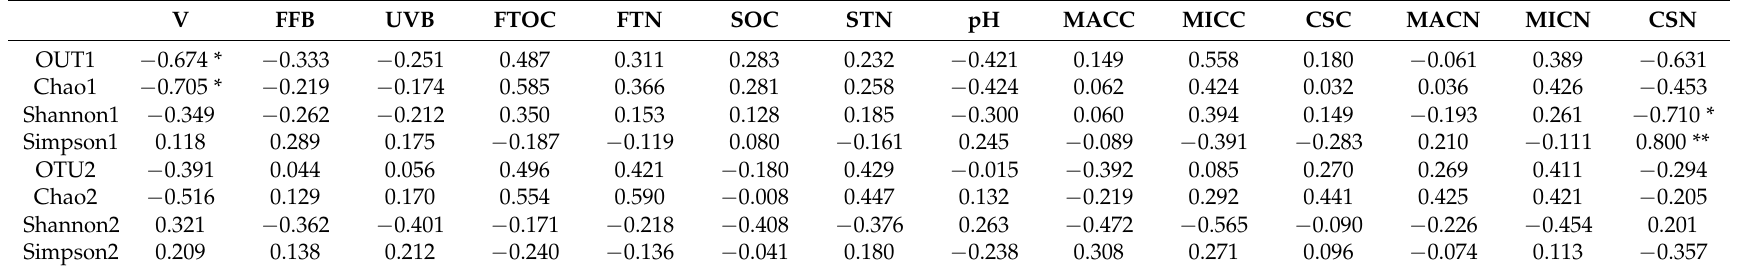
Table A2. Pearson correlation between tree growth, soil properties, and soil microbial